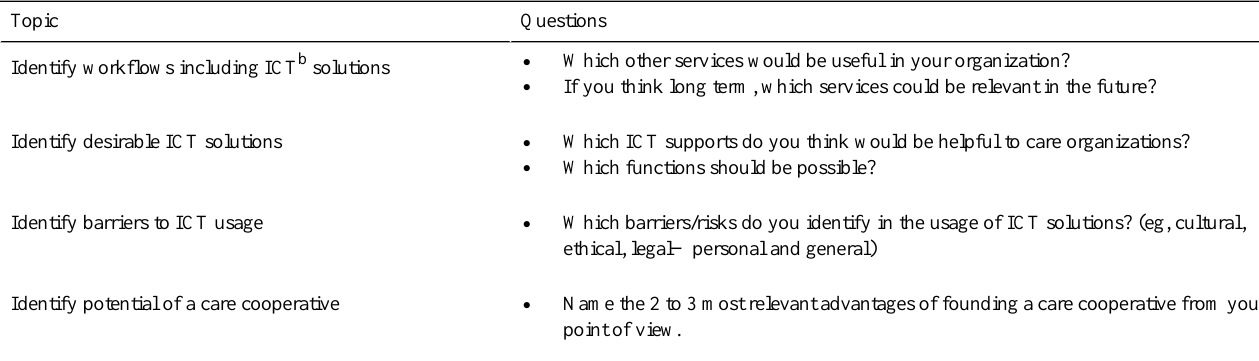
Table 1. Open-ended questions in the topic guide for focus groups from three perspectives. a